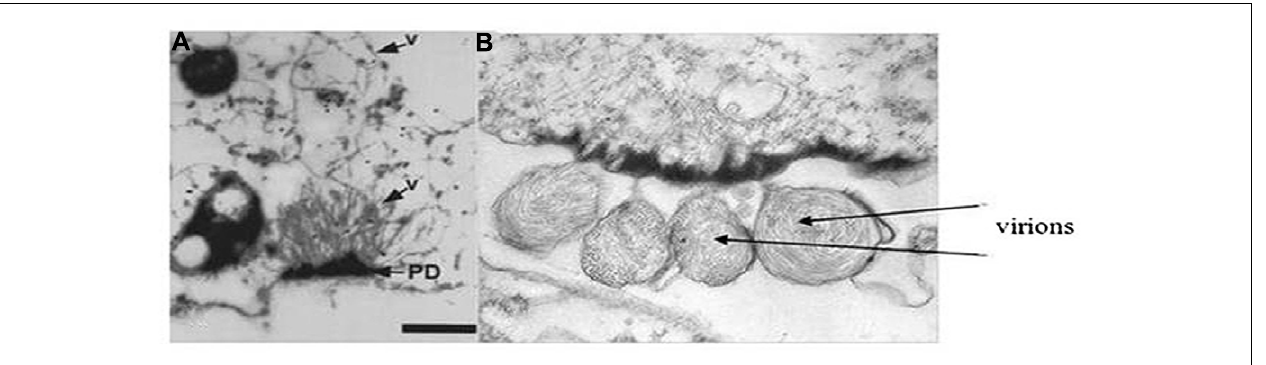
FIGURE 7 |Transmission electron micrographs showing (A) virions (see arrow andV) extending from the plasmalemma deposits (PD) and into the cytoplasm of a LIYV-infected N. benthamiana protoplast (image is